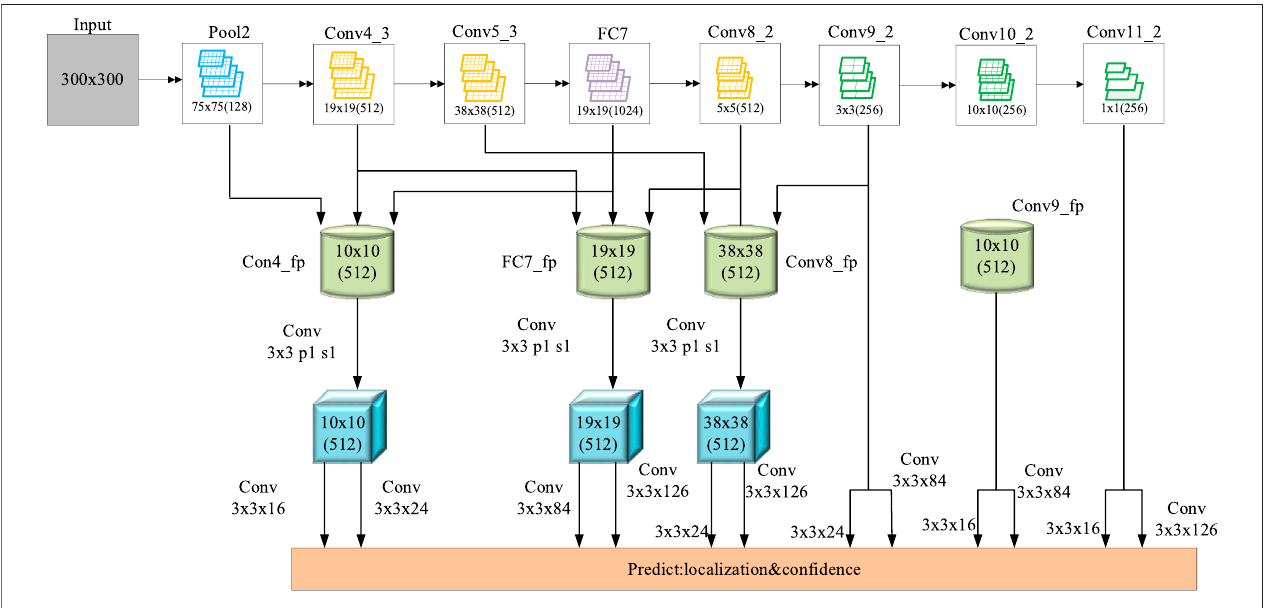
FIGURE 3 | Design of target detection network based on synchronous sensor network.